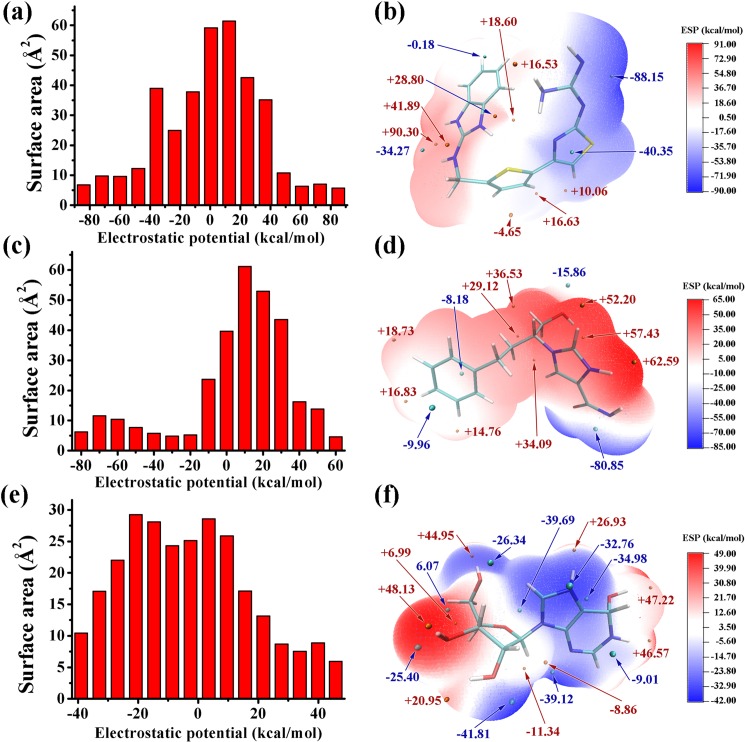
Electrostatic potential information of the three ligands: FR0, FR2, and PRH.Surface area in each electrostatic potential (ESP) ranges on the vdW surface of (a) FR0 (c) FR2 and (e) PRH. ESP-mapped molecular vdW surface of (b) FR0 (d) FR2 and (f) PRH.